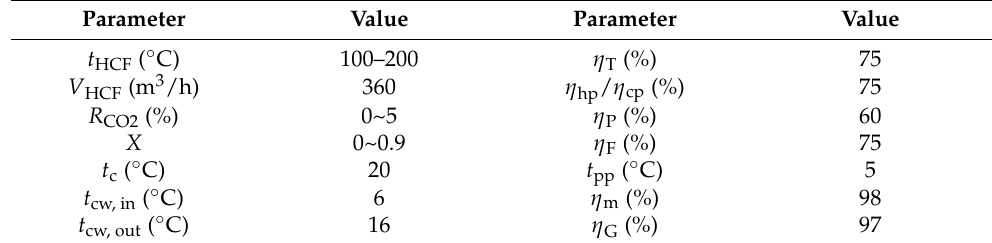
Table 5. Relevant parameters of the energy conversion